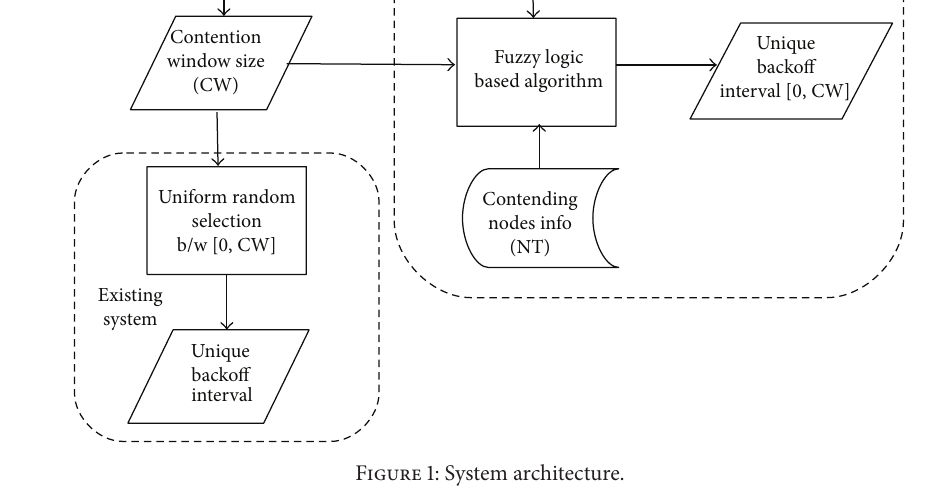
Figure 1: System architecture.